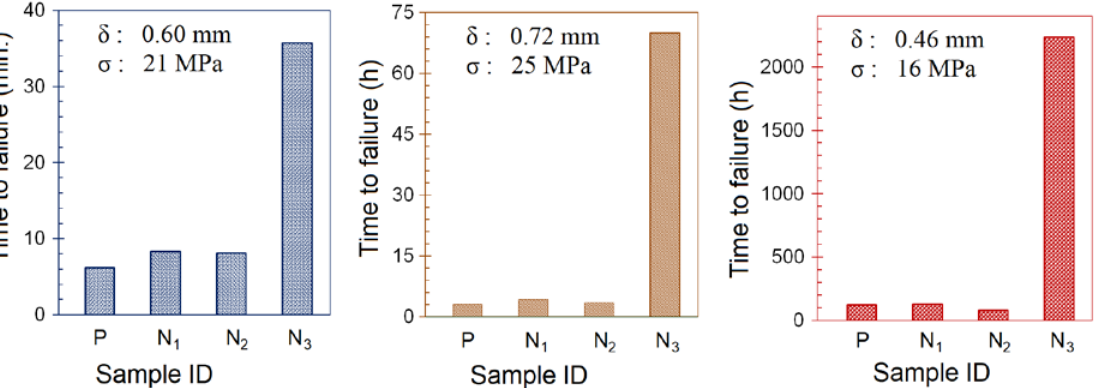
Figure 7. Bar charts showing time-to-fracture for PC and PC/TiO 2 composites after ESC tests in DOP oil under different temperatures and pre-strain values.